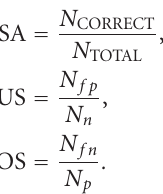
algorithm performance in terms of three parameters defined